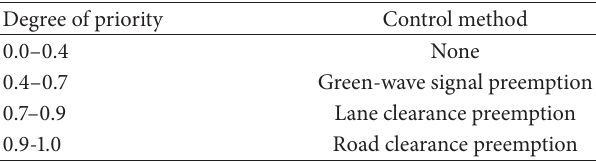
Table 2: Emergency vehicle control method choice